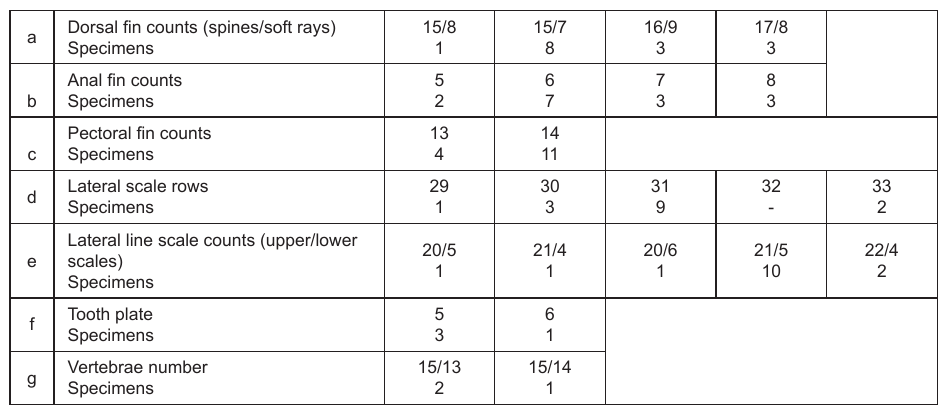
Table 4. Comparison of proportional measurements in % SL and counts of Badis singenensis sp. nov. with related Proportions